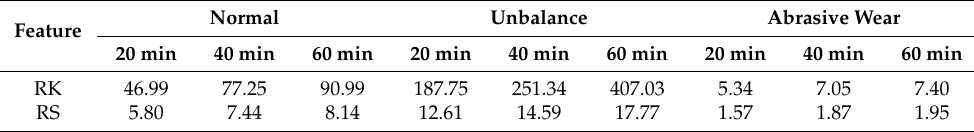
Table 5. Relative Skewness and Relative Kurtosis of Particle Distributions at the three conditions. Feature